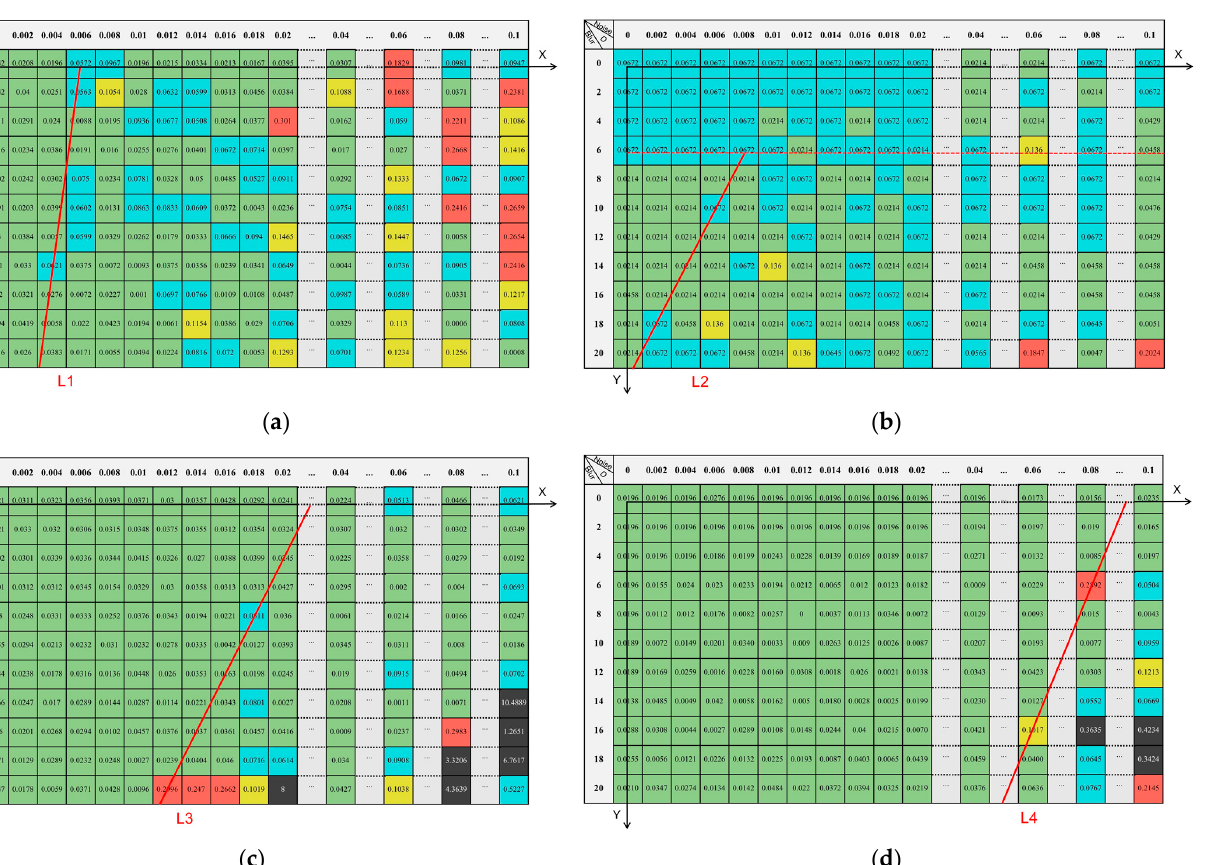
Table 5. Distribution and proportion of the grade of the test results by different methods.